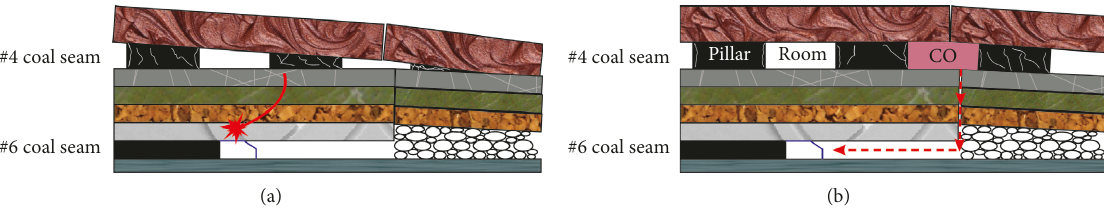
Figure 3: Schematic diagram of potential hazards at the #6 seam coalface in Yuanbaowan mine. (a) Dynamic impacts resulting from sudden fracture of the exposing roof. (b) Entrance of hazardous and poisonous gas into the panel after the interconnection between the